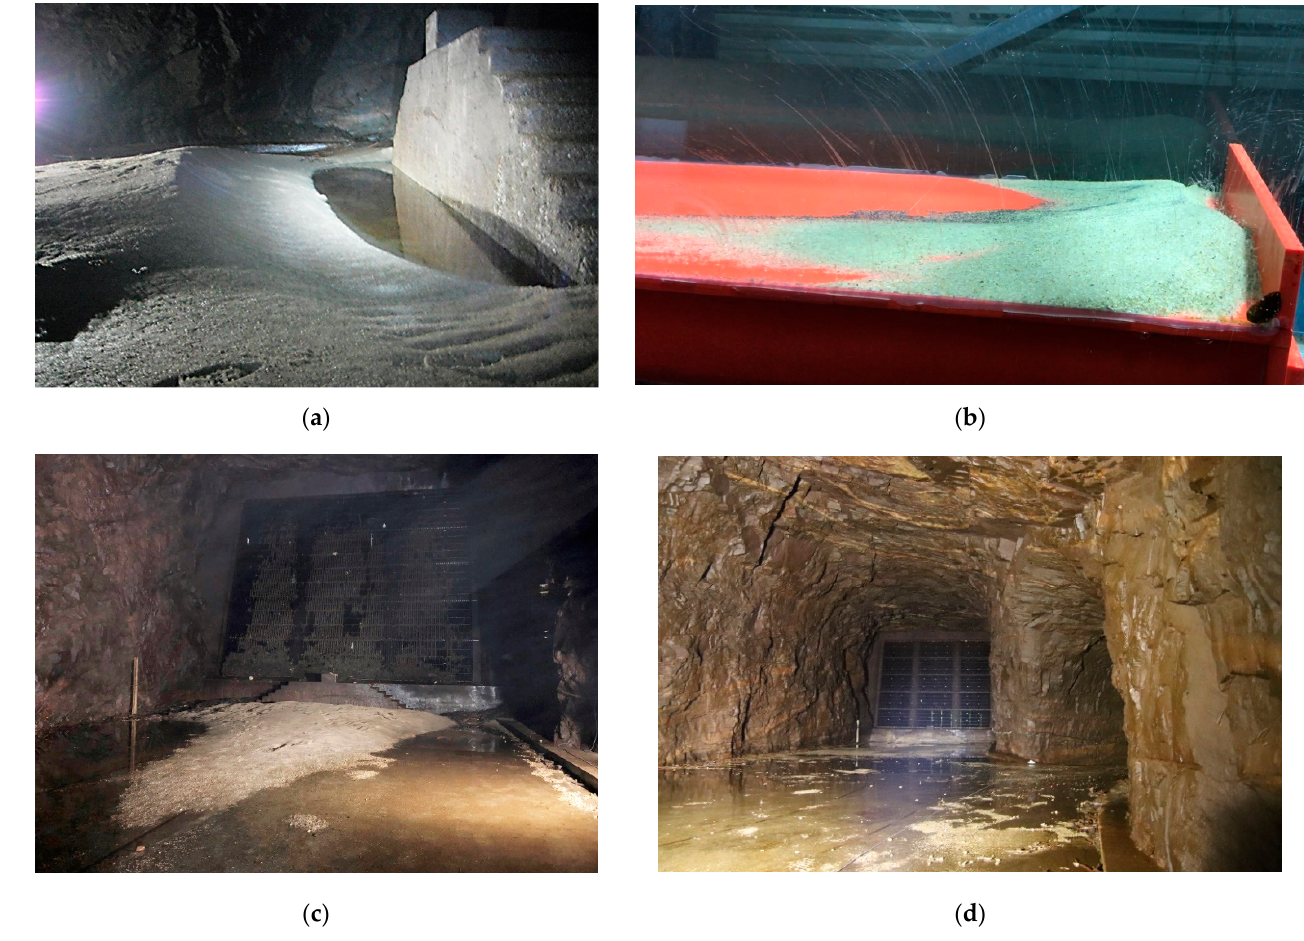
Figure 15. Sand accumulation at the downstream weir of the pressurized sand trap. ( a , c ) Prototype, original design, sand accumulation, and dune observed upstream from the weir after dewatering; ( b ) Physical scale model test, original design, showing a comparable deposition pattern, and continuous particle transport over the weir; ( d ) Prototype weir, inlet rake to pressure shaft, and access tunnel after manual sediment